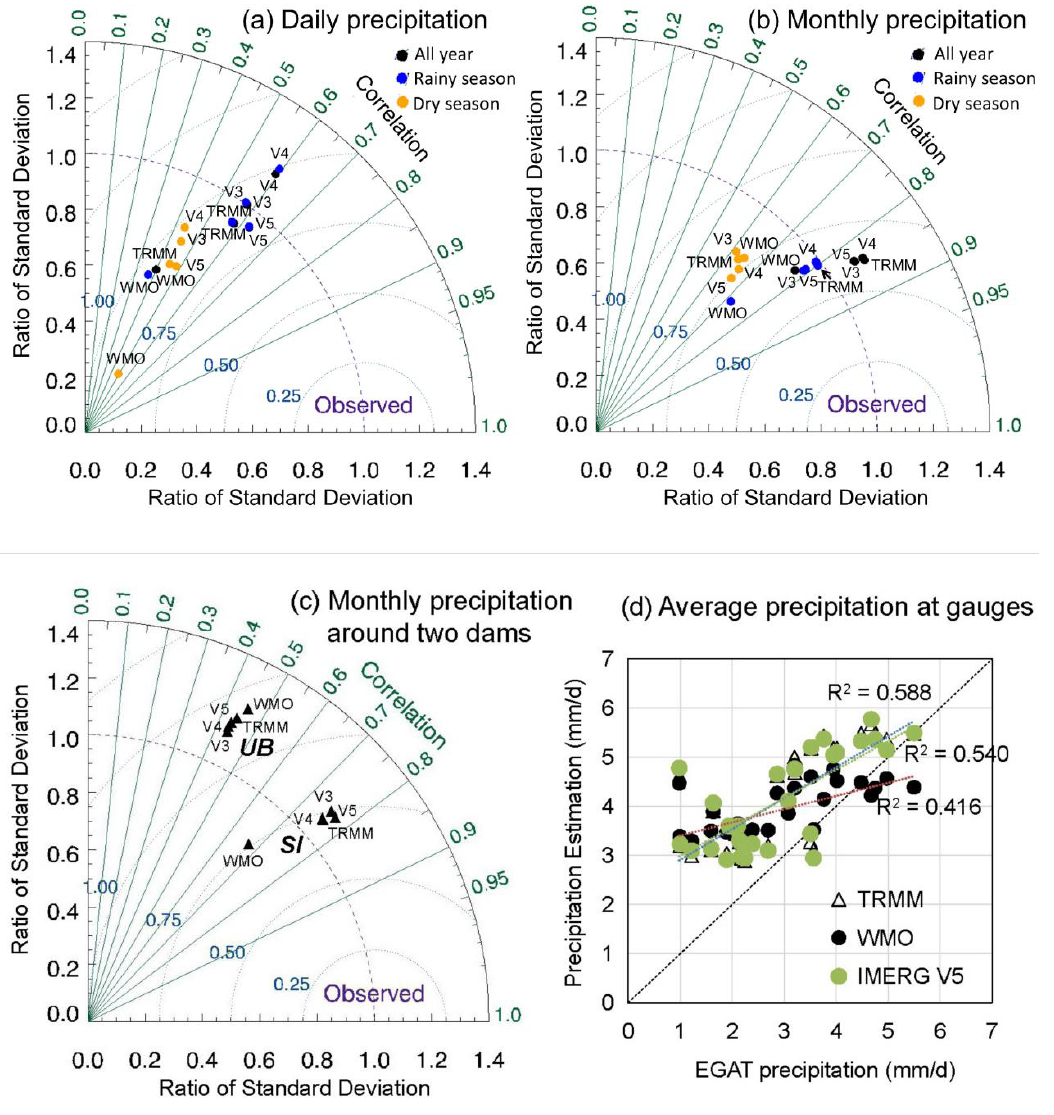
Figure 2. Taylor diagram of daily and monthly statistics among the multi-satellite retrievals for Global Precipitation Measurement (IMERG) V03, IMERG V04, IMERG V05, Tropical Rainfall Measuring Mission (TRMM), and World Meteorological Organization (WMO) interpolation grids from 12 March 2014 to 31 January 2016: ( a ) Daily precipitation during rainy season, dry season, and for the whole period. ( b ) Monthly precipitation during rainy season, dry season, and for the whole period; ( c ) monthly precipitation around two dams; ( d ) total precipitation at each gauge.